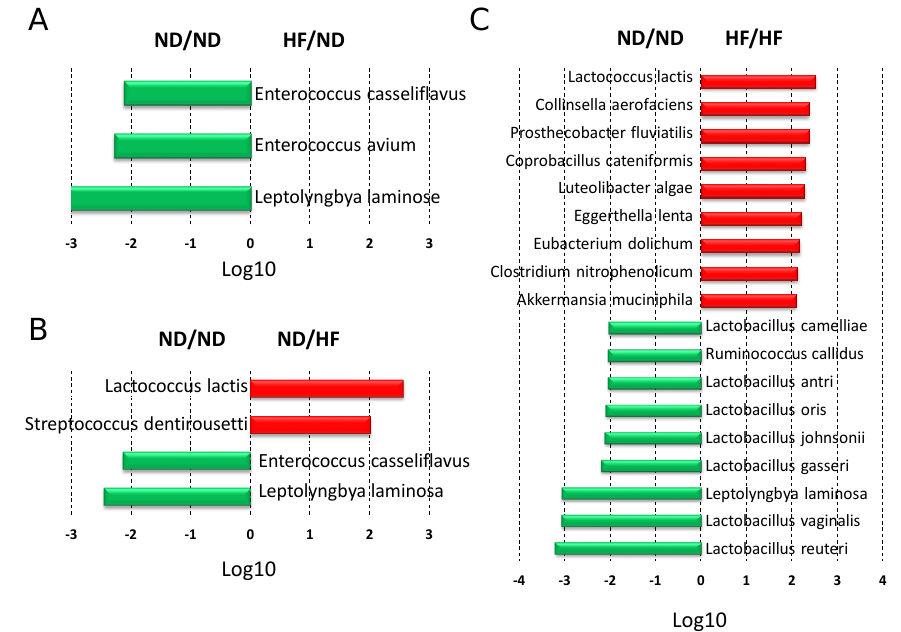
Figure 7. Effect of maternal and post-weaning high-fructose (HF) diet on 16-week-old offspring gut microbiota at the species level. Linear discriminant analysis (LDA), along with effect size measurements, was applied to identify enriched bacterial species. Most enriched and depleted species (LDA score (log10) >2.0) in the ( A ) HF/ND (red) vs. ND/ND (green), ( B ) ND/HF (red) vs. ND/ND (green), and ( C ) HF/HF (red) vs. ND/ND (green). n = 8/group.